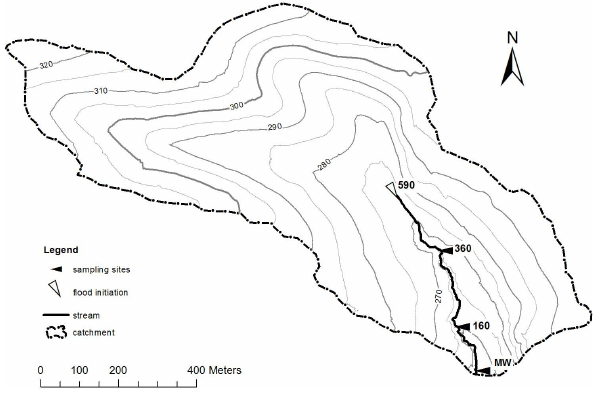
Fig. 1. Natural event with single peaking hydrograph and double peaking sedigraph in the HOAL Petzenkirchen catchment (0.64ha) on 28 July 2012.